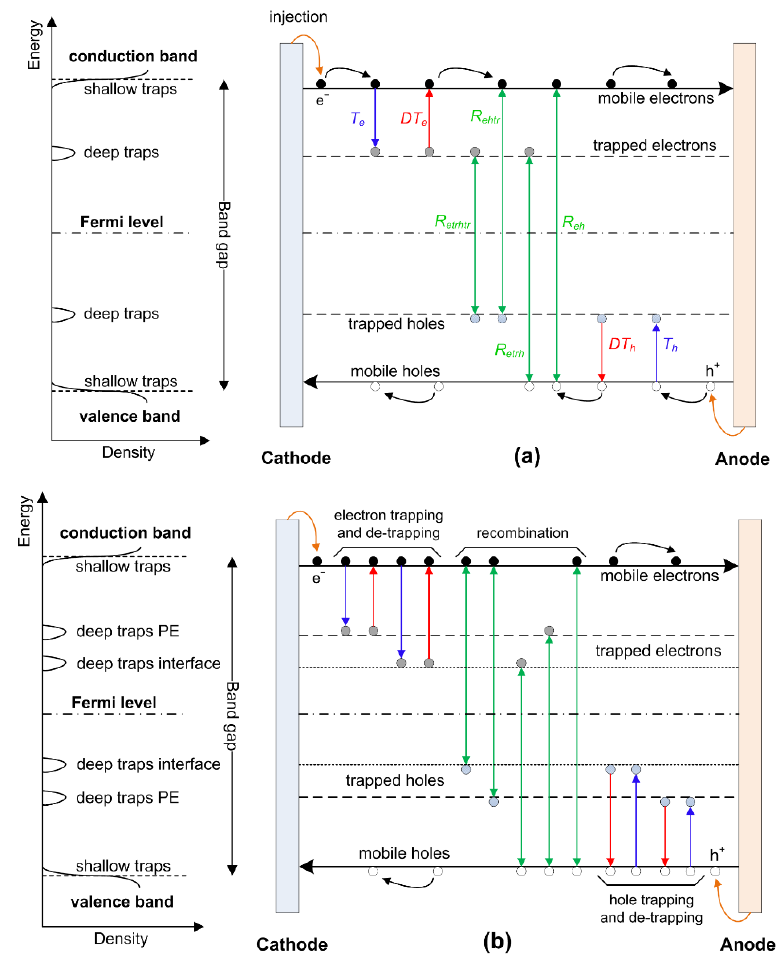
Figure 8. Schematic representation of charge generation and transport of the model used in present study; ( a ) pure LDPE and ( b ) nanofilled LDPE. Symbols T e,h denote trapping, DT e,h — de-trapping, and R eh,ehtr,etrh,etrhtr — recombination processes. Table 6. Parameters of the charge transport model used in the present study.